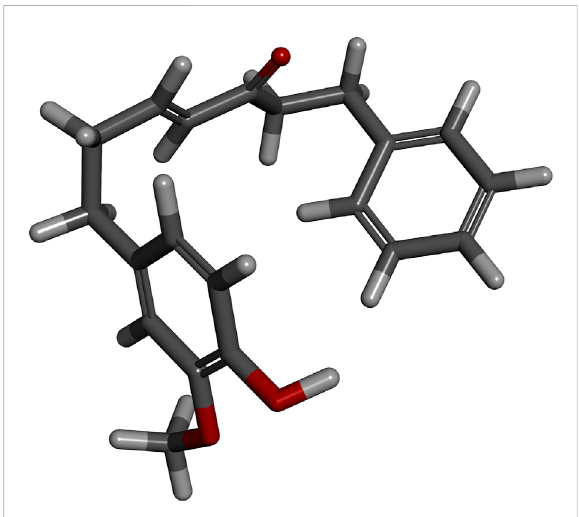
FIGURE 1 Three-dimensional spatial structure of DPHB. Red sticks: oxygen atoms; white sticks: hydrogen atoms; and gray sticks: carbon